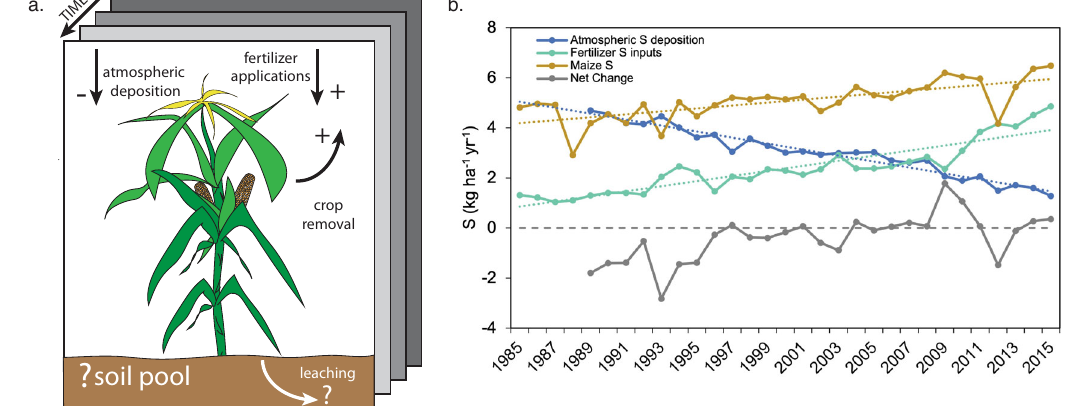
Fig. 1 Mass balance estimate of S in agriculture from 1985 – 2017. a Conceptual model of S fl ows. b Trends in S inputs and estimated S output in maize. Areal loads are calculated as the total amount of S normalized by the total land area of the study region (atmospheric S deposition), the total cropland in the study region (all S fertiliser products), and area of maize planted (maize S). Best fi t lines are slope = − 0.12 kg S ha − 1 yr − 1 , R 2 = 0.96 (atmospheric S deposition), 0.10 kg S ha − 1 yr − 1 , R 2 = 0.82 (fertiliser S inputs), and slope = 0.06 kg S ha − 1 yr − 1 , R 2 = 0.46 (maize S). The linear models are statistically signi fi cant ( p < 0.001). The slopes of all regression lines are signi fi cantly different from zero ( p < 0.0001). The mass balance estimate (i.e., atmospheric S deposition and fertiliser inputs less maize S export) is shown for reference. A negative value indicates that atmospheric S deposition plus fertiliser S application exceed losses from maize export. A positive value shows that atmospheric S deposition plus fertiliser S application does not compensate for losses from maize